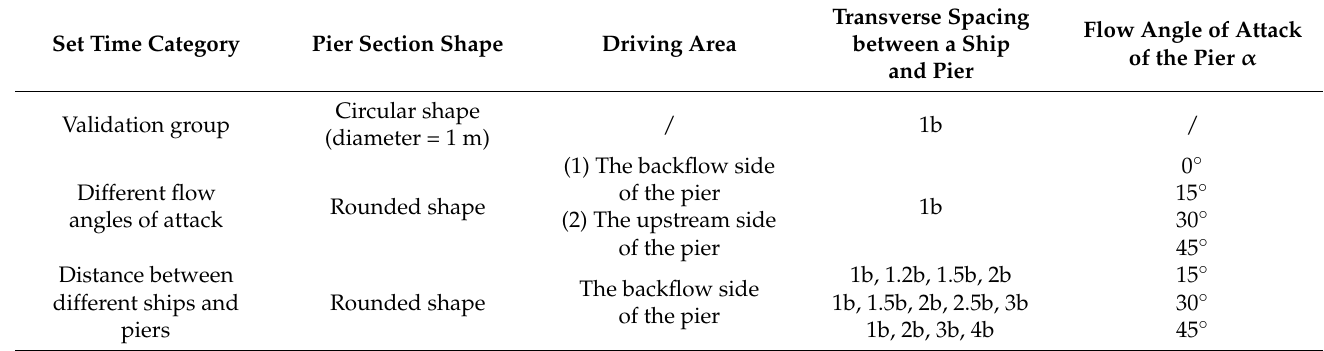
Table 2. Numerical simulation table for ship–bridge intersection in skew bridge